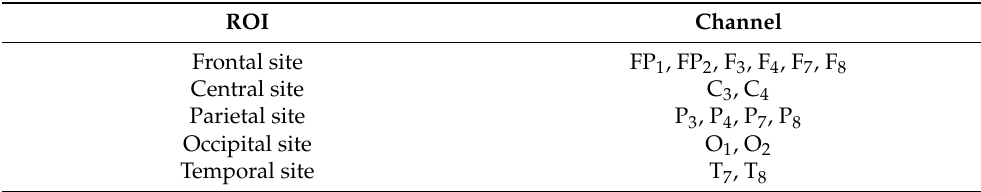
Table 2. Definition of recording site of the